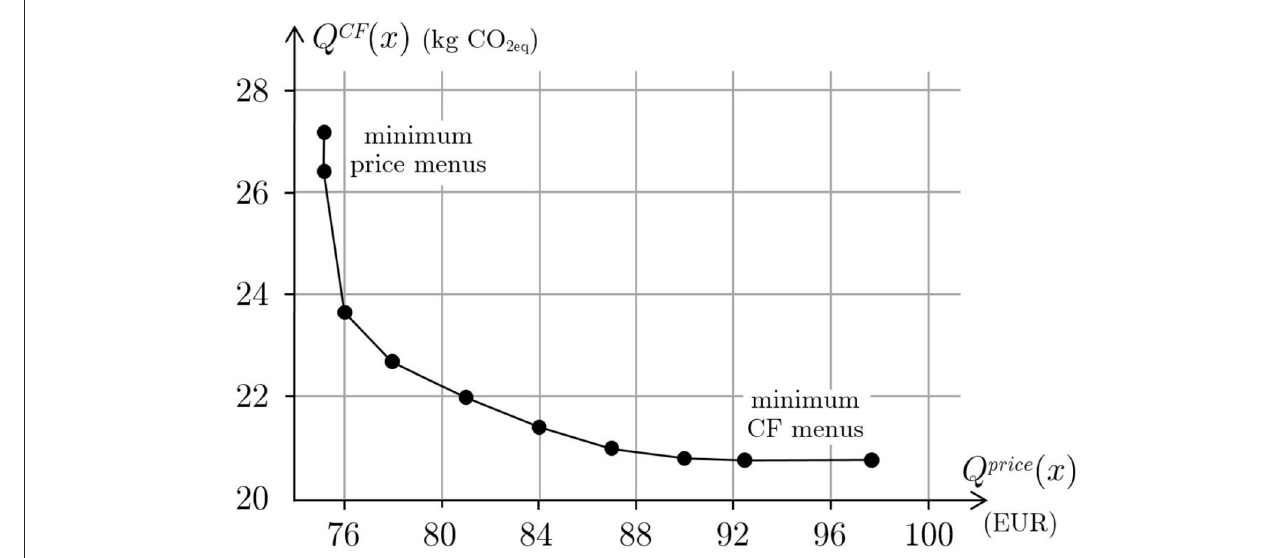
FIGURE 5 | Relation between the price and the carbon footprint of optimal menus.